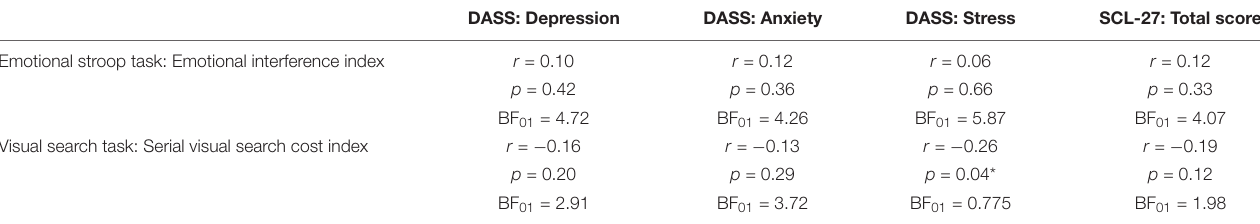
TABLE 5 | Frequentist and Bayesian correlation matrix in T1 between behavioral tasks scores and wellbeing variables. DASS: Depression DASS: Anxiety DASS: Stress SCL-27: Total score